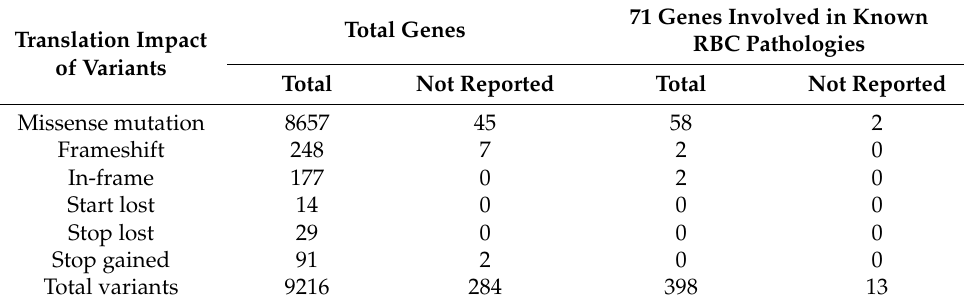
Table 2. Summary of the translation impact of variant (mutations/polymorphisms) types for all variants identified in both patients with